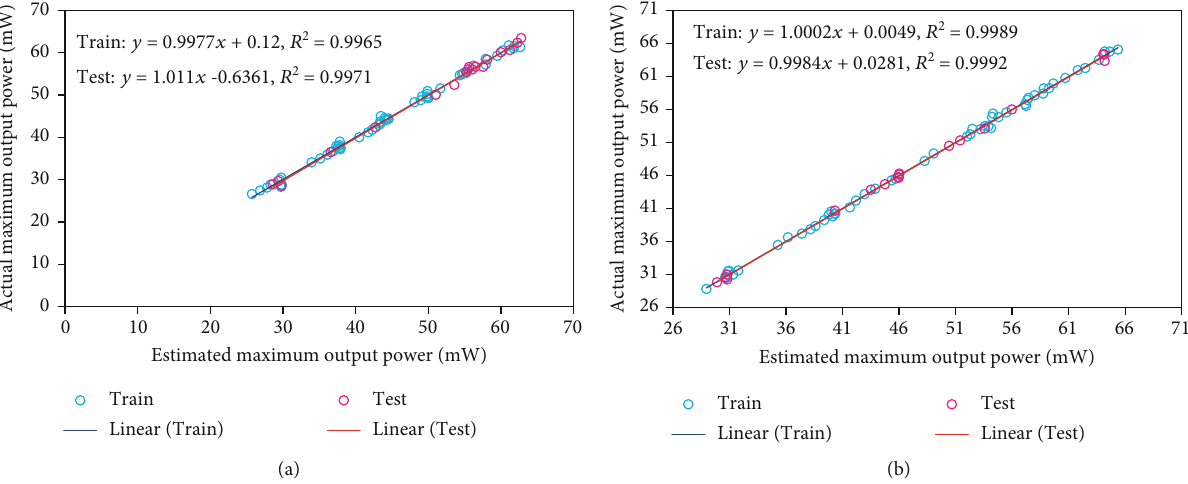
Figure 6: The cross plot of experimental and predicted maximum output power by LSSVM for (a) monocells and (b)